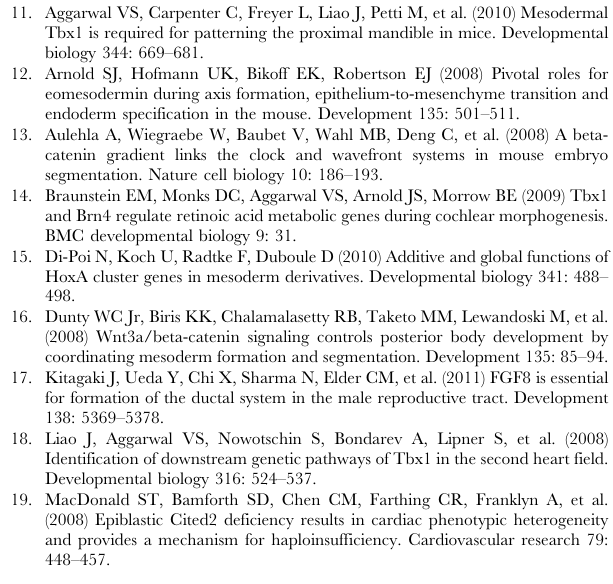
Figure S1 Efficient TCreERT2-mediated deletion of ß- catenin in E8.5 embryos. After a 48-hour Tam induction, embryos were hybridized with a probe for the ß-catenin sequences that are deleted by Cre. Compared to the control genotype (top panel), TCreERT2; ß-catenin flox/null embryos display an efficient deletion of ß-catenin (bottom panel). When this experiment is performed with embryos harvested at E10.5, after a similar 48- hour Tam induction, the ß-catenin probe results in a signal that is too weak in control embryos to be meaningful in experimental TCreERT2; ß-catenin flox/null